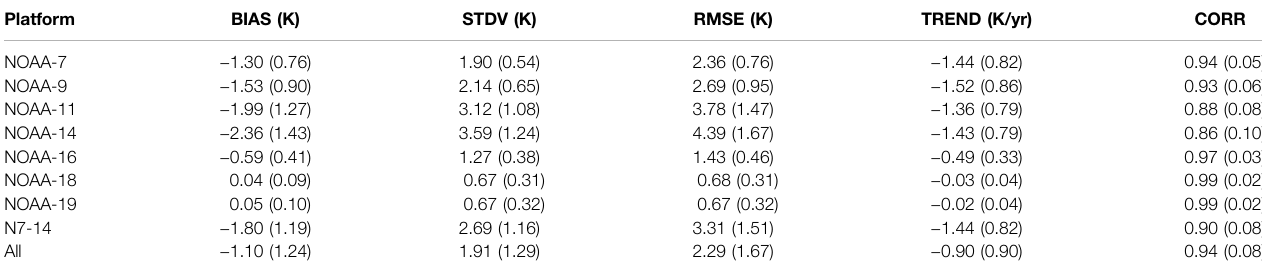
TABLE 3 | Statistical assessment of the orbital drift effect on LST for each NOAA platform, for NOAA-7 to 14 platforms, and overall: average value over all sites with its standard deviation in parentheses. STDV: standard deviation; RMSE: root mean square error; TREND: the lineal trend of the difference between drifted and reference time series; CORR: the correlation value between both time series.